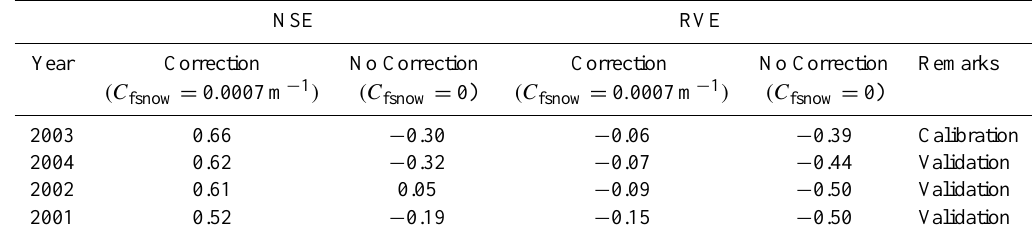
Table 4. Discharge error components (NSE and RVE) for calibration and validation periods (after and before correction).